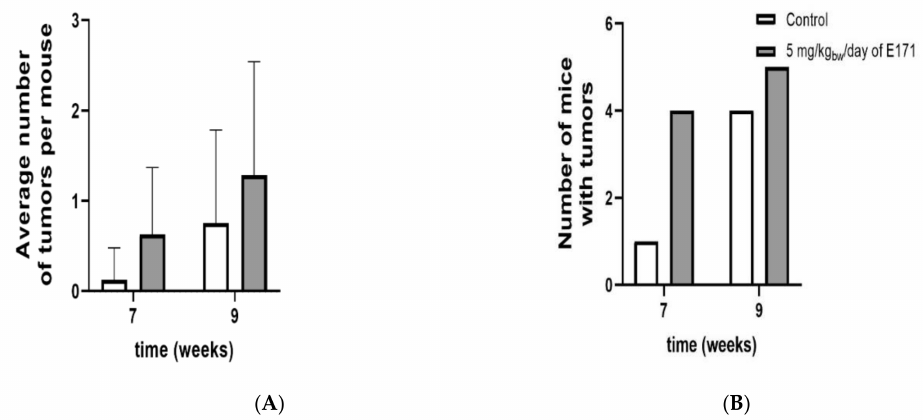
Figure 4. Tumor formation in the colon of Tg mice exposed to 5 mg/kg bw /day of E171 via intragastric gavage for 7 and 9 weeks. ( A ) shows the average number of tumors per mouse. ( B ) shows the number of mice bearing tumors. Data in ( A ) is presented as the mean of each group (n = 8 for each group for 7 and 9 weeks; n = 7 for control 7 weeks and 5 mg/kg bw /day of E171 for 9 weeks). E171 exposure showed a statistically nonsignificant increase in the number of tumors per mouse as well as the number of mice with